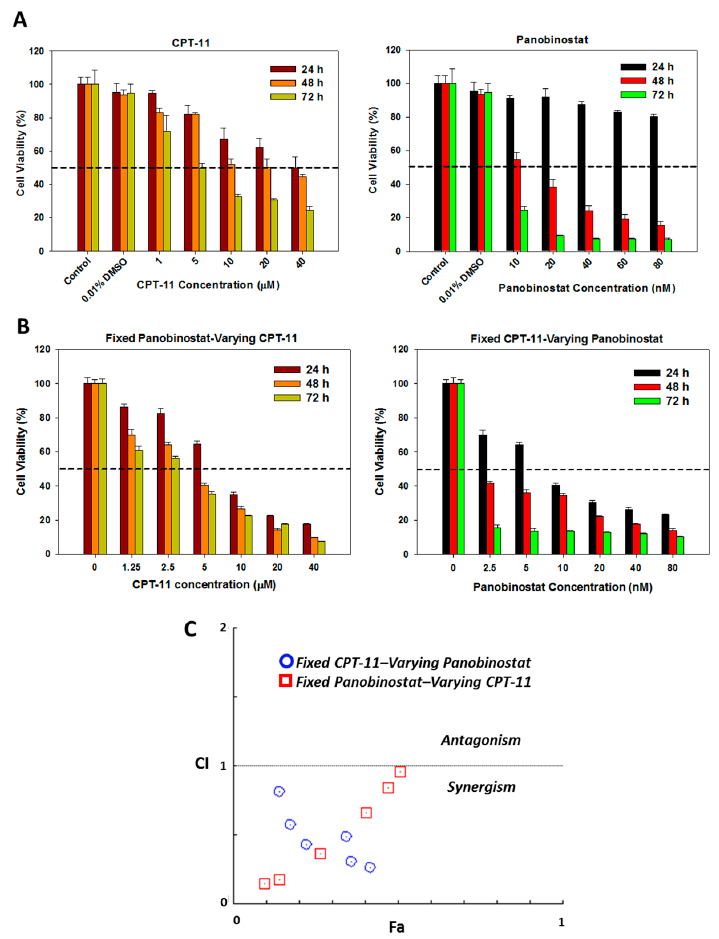
Figure 6. The cytotoxicity of single drug (CPT-11 or panobinostat) ( A ) and dual drug (CPT-11 and panobinostat) ( B ) toward U87DR at different time points ( n = 5). ( C ) The synergistic effect of drug combination was analyzed by CompuSyn software with results taken from ( B ), from which the combination index (CI) value could be used to categorize the drug interaction into synergism (CI < 1), additive (CI = 1) and antagonism (CI > 1).